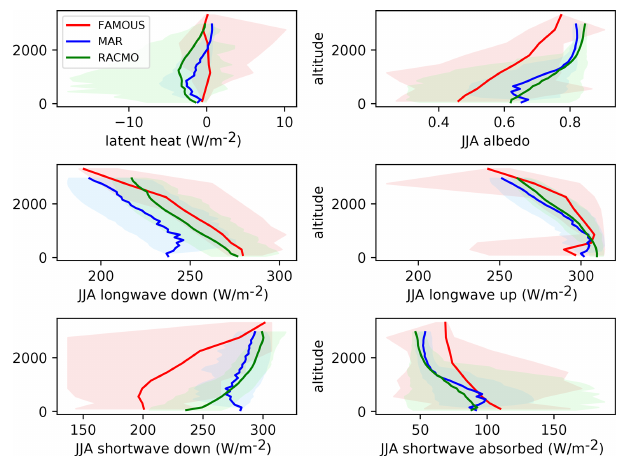
Figure 2. Profiles of surface exchange characteristics taken from every surface modelled on the Greenland ice sheet binned by sur- face elevation. Red: FAMOUS-ice; blue: MAR (1980–1999) (Fet- tweis et al., 2013); green RACMO (1980–1999) (Noël et al., 2018). FAMOUS-ice and MAR are forced by the MIROC5 climate (1980– 1999) (Watanabe et al., 2010), and RACMO is forced by ERA- Interim (1980–1999) (Dee et al., 2011). Latent heat is an annual average; negative values imply sublimation. Shading represents the full range of values found in each time-averaged elevation bin.